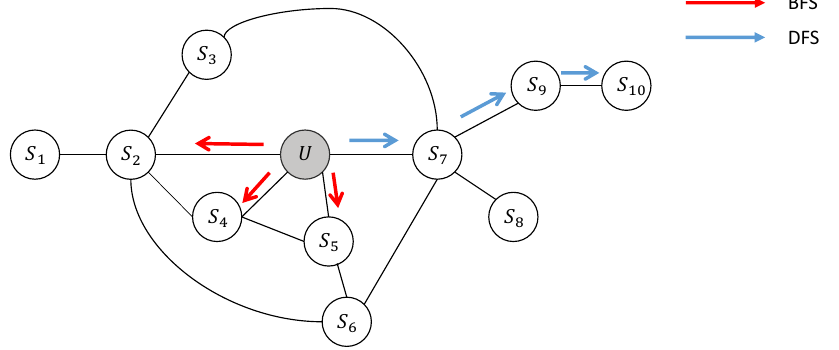
Figure 3. BFS and DFS policies on node U.